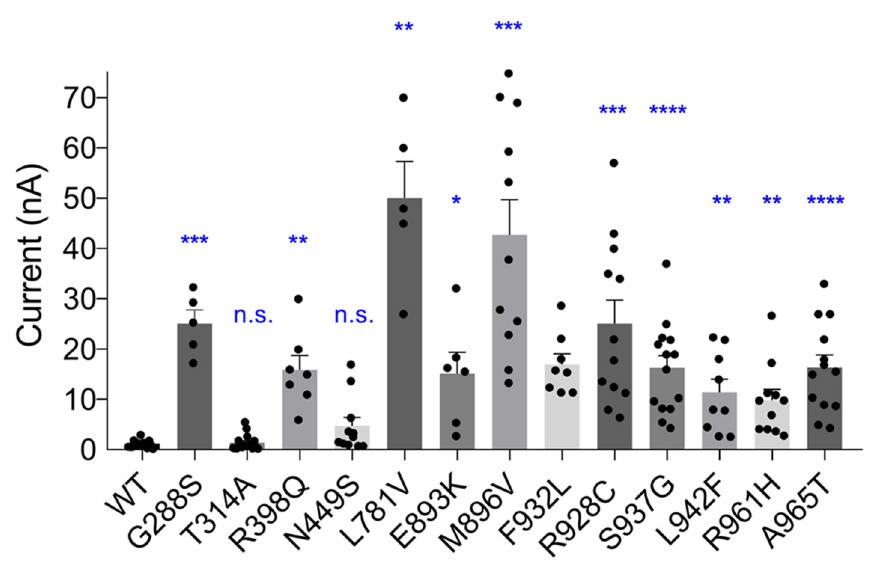
Figure 2. The effect of GoF mutations on KCNT1 current amplitude. The average amplitudes of WT and GoF mutant KCNT1 currents, measured at +10 mV using I-V plots similar to those shown in Figure 1. Brown-Forsythe and Welch’s ANOVA tests with multiple comparisons produced significant difference between the amplitude of WT and each mutant current, except T314A and N449S. Calculated individual p values were as follows: G228S—0.0009; T314A—0.6136; R398Q—0.0022; N449S—0.0535; L781V—0.0026; E893K—0.0224; M896V—0.0001; F932L—0.0001; R928C—0.0004; S937G—<0.0001; L942F—0.0049; R961A—0.0024; A965T—<0.0001. The dots on the graph represent current amplitudes in individual cells; the asterisks denote the level of the significance (*—<0.05; **—<0.01; ***—<0.001; ****—<0.0001); n.s.—not significant. (Note: The amplitudes of the largest currents are underestimated due to a residual uncompensated series resistance. See Section 4).